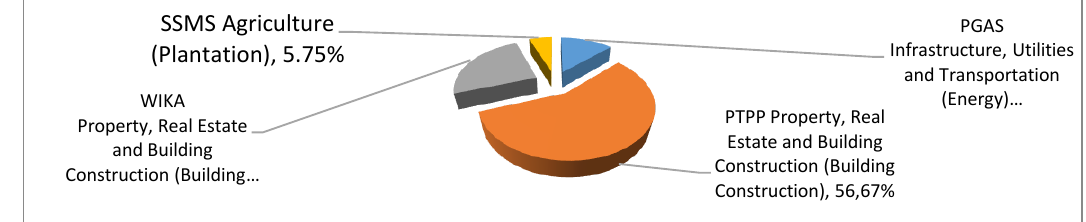
Figure 7 Semester 1 2015 Portfolio